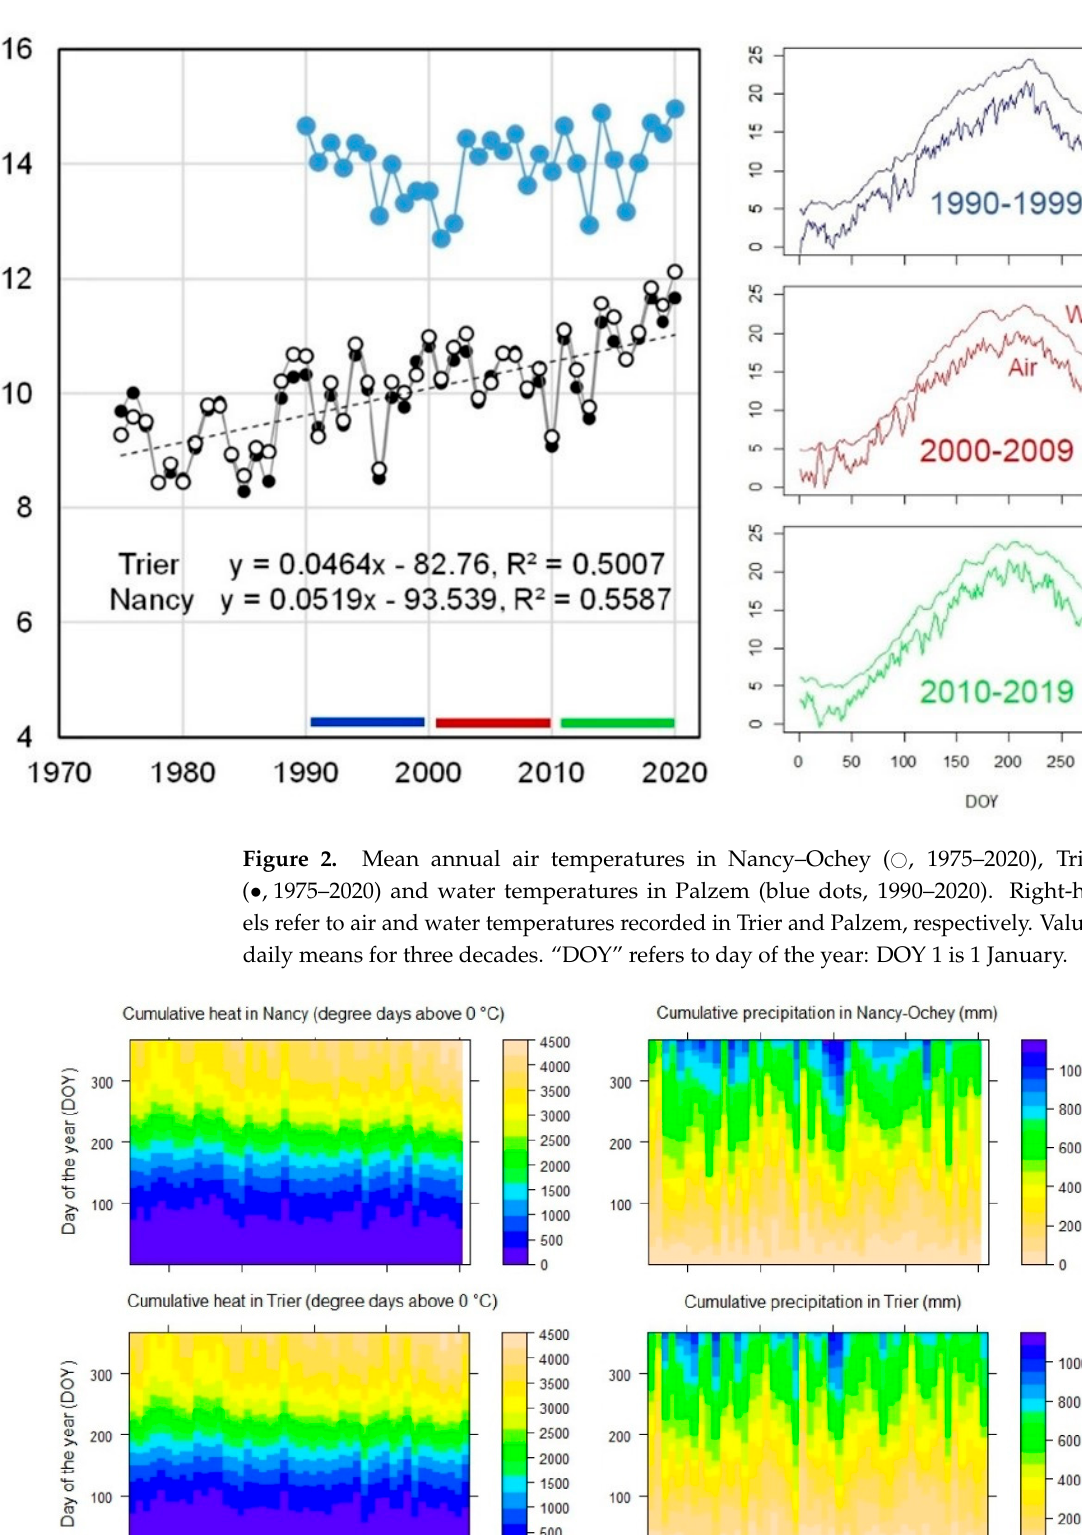
Figure 2. Mean annual air temperatures in Nancy–Ochey ( ○ , 1975–2020), Trier − Petrisberg ( ● , 1975– 2020) and water temperatures in Palzem (blue dots, 1990–2020). Right-hand side panels refer to air and water temperatures recorded in Trier and Palzem, respectively. Values are given as daily means for three decades. “DOY” refers to day of the year: DOY 1 is 1st of January.